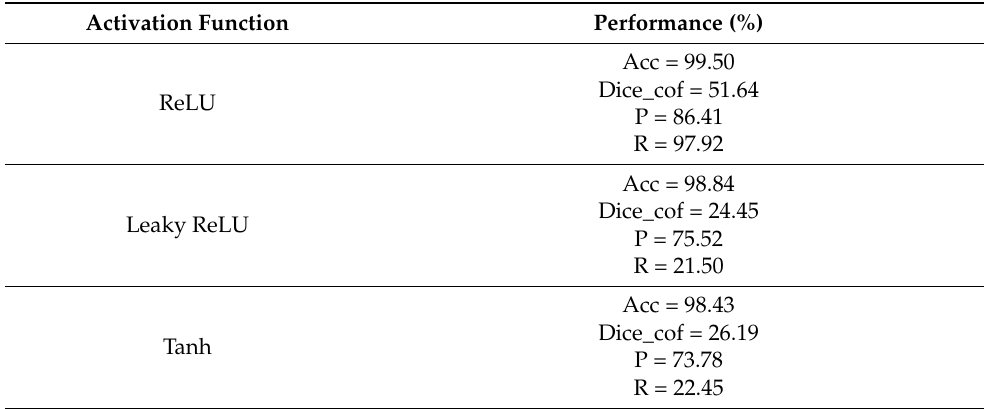
Table 5. Comparison of our method using ReLU activation function and other nonlinear activation functions.